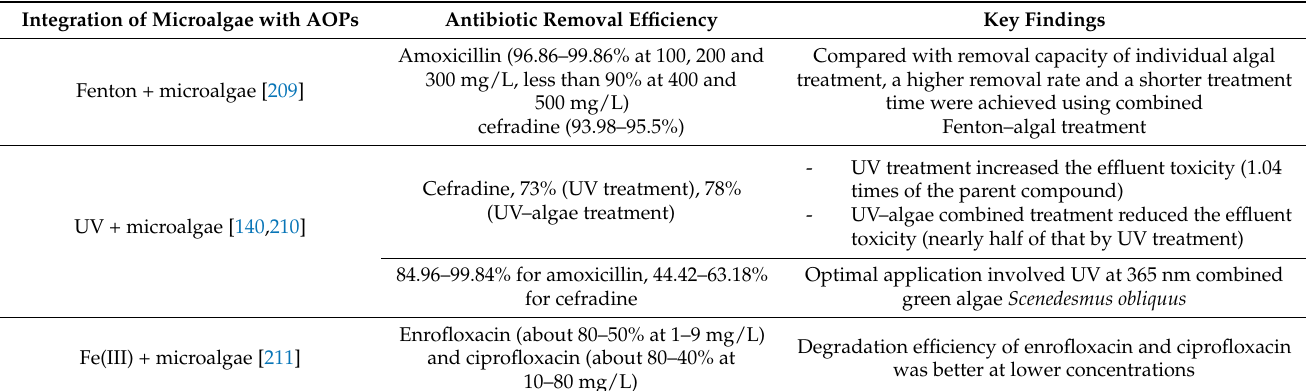
Table 6. Integration of microalgae with AOPs for antibiotic